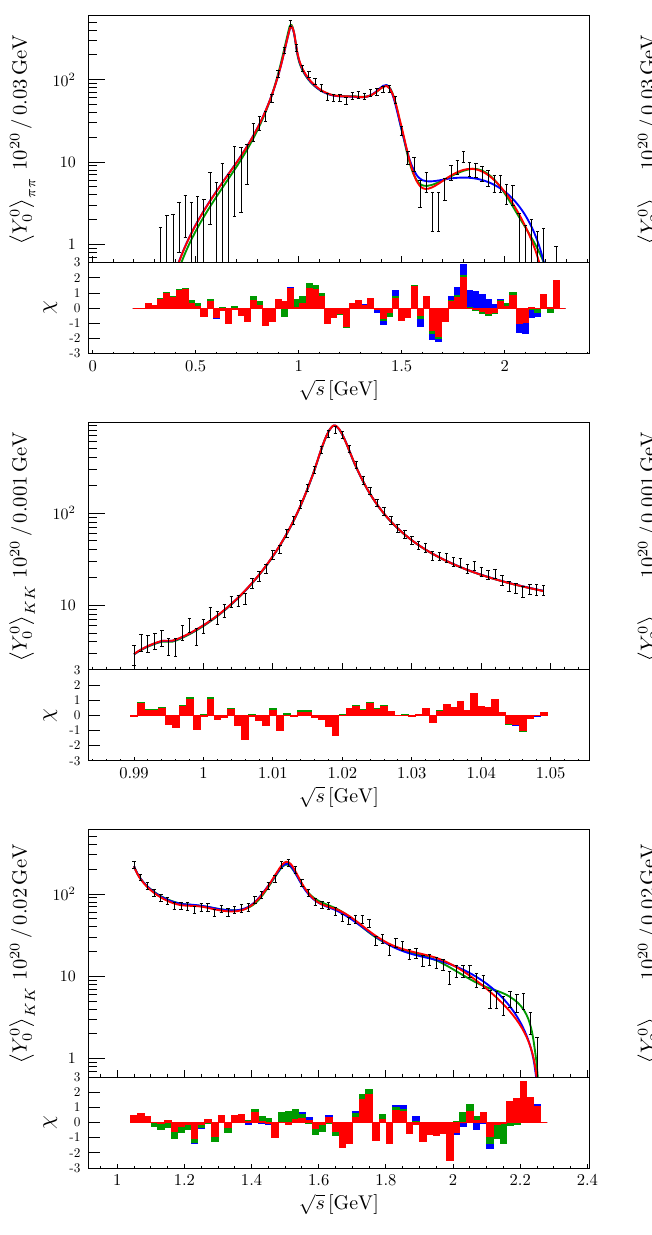
Fig. 4 Angular moments J /ψ π + π − (top two) and ¯ B 0 s → J /ψ K + K − (bottom four) with an effective ρρ channel. The picture shows Fit 1 in blue,